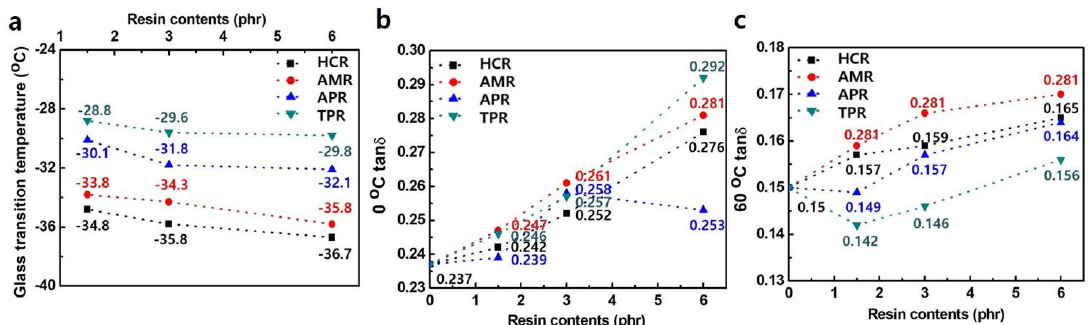
Figure 4. Dynamic properties of the rubber composites: ( a ) glass transition temperature (Tg) of the rubber composites with varying content fractions of different resins, ( b ) 0 °C tan δ of the rubber composites with varying content fractions of different resins, and ( c ) 60 °C tan δ of the rubber composites with varying content fractions of different resins.